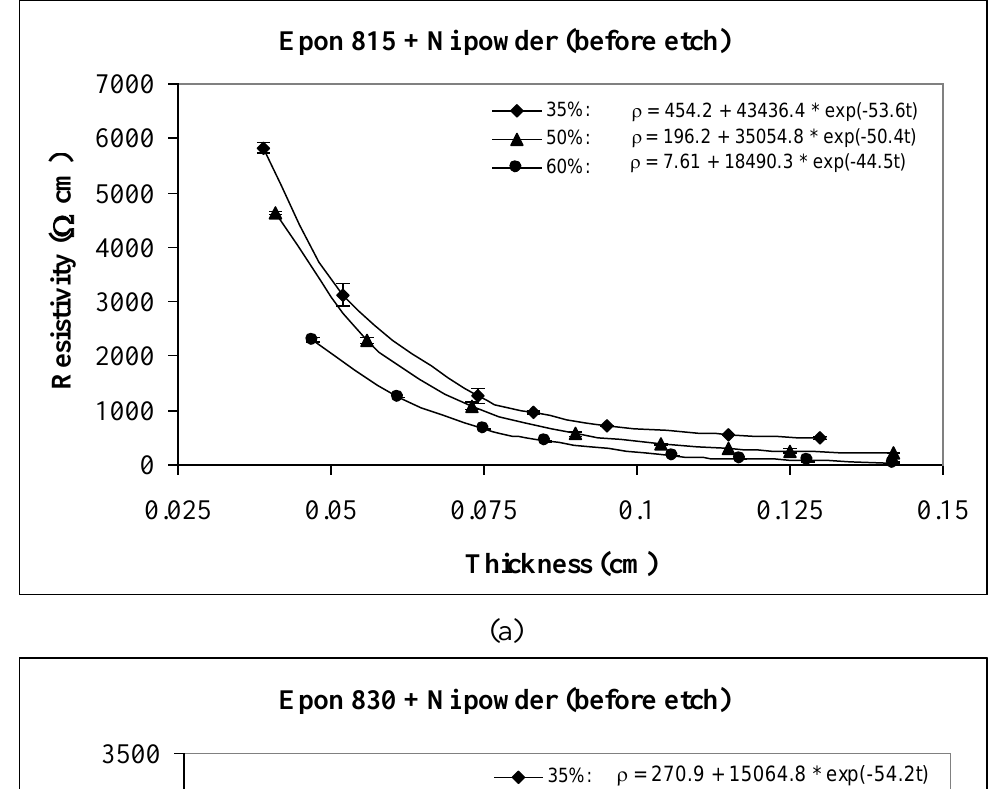
Figure 5. Thickness-dependent resistivity of Epon 815C ( a ), and 830 ( b ) films filled 35%, 50%, 60% by volume with unetched nickel powder. Epon 815 + Ni powder (before